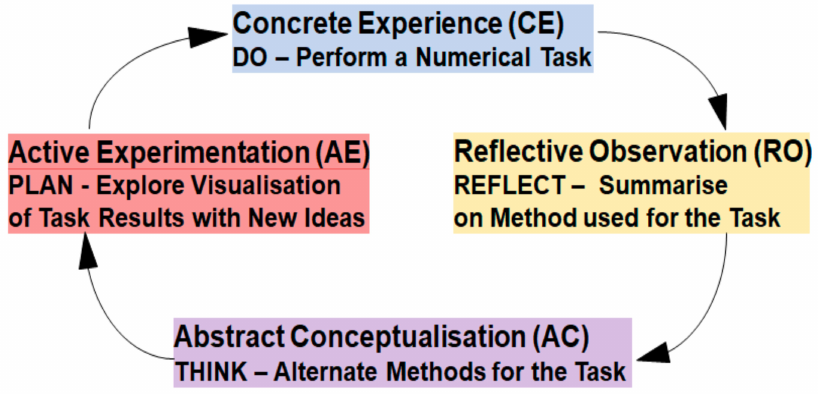
Figure 4. Experiential Learning Implementation of a Learning